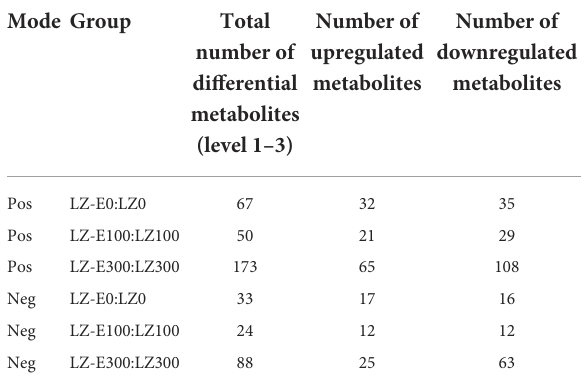
TABLE 2 Differentially expressed metabolites of E + and E– barley under salt